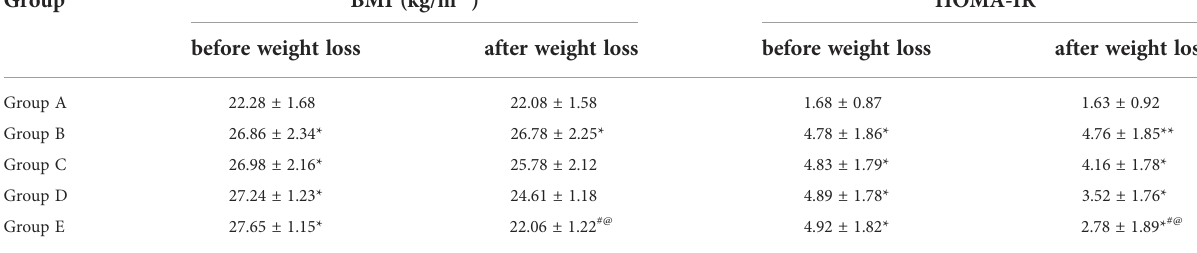
TABLE 3 BMI and